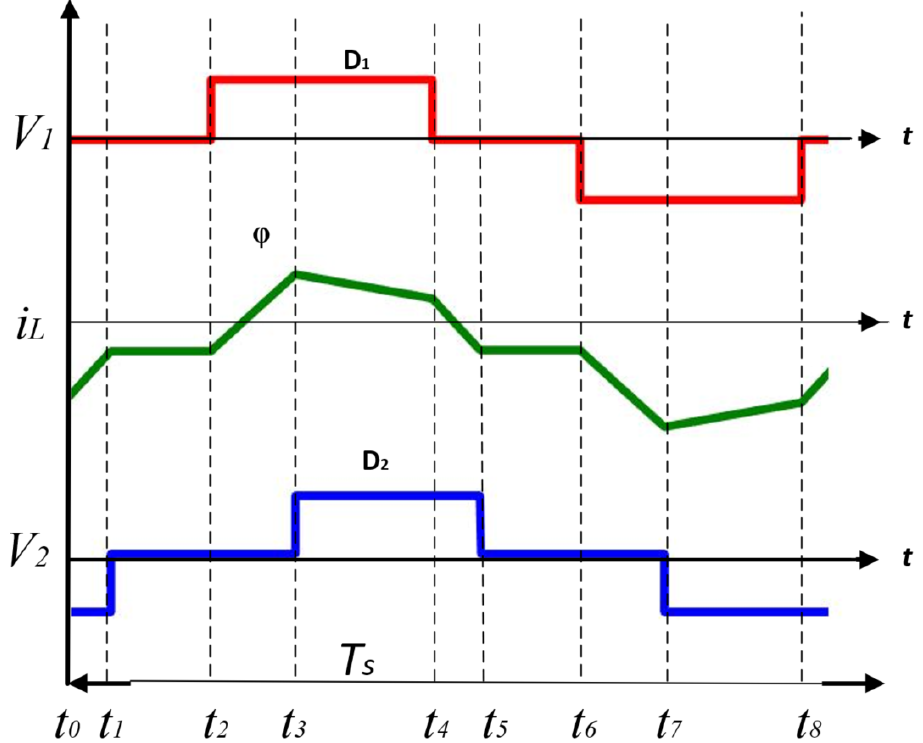
Figure 4. Primary and secondary voltages, and current under the TPS modulation method for